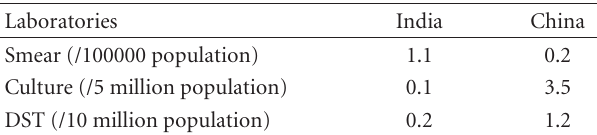
Table 1: Microbiology facilities 2010 (adapted from WHO report 2009)